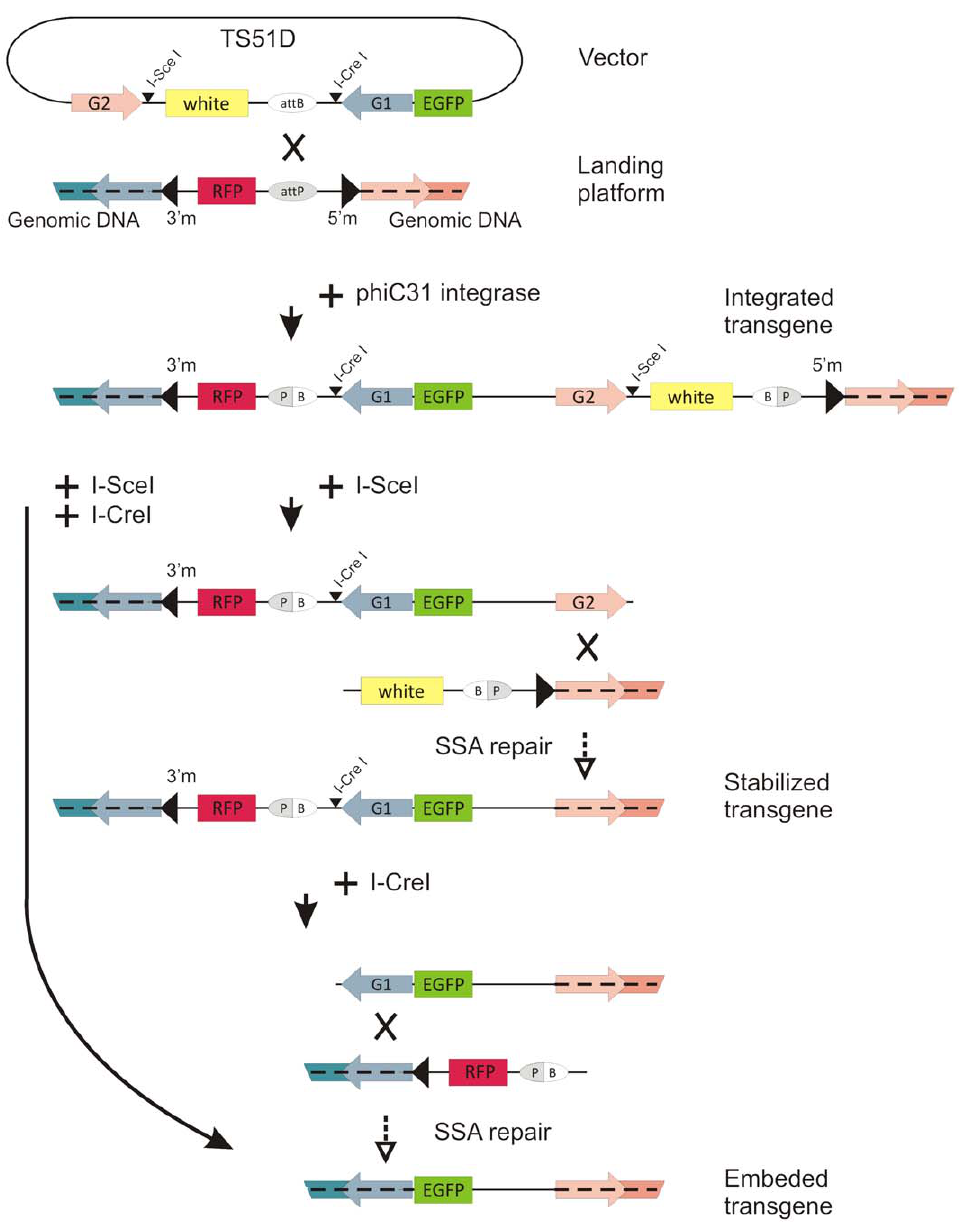
Figure 1. TS51D vector stabilization strategy after site specific integration in genome. Complete stabilization may be achieved in two steps (DSB introduction at I-SceI and then at I-CreI), or in one (simultaneous expression of two endonucleases). The breaks are repaired due to duplications of sequences flanking landing platform. Genomic sequences homologous to G1, G2 are highlighted corresponding to G1 (blue) and G2 (pink). Final insertion does not contain transposone sequences and, therefore, is immobile.